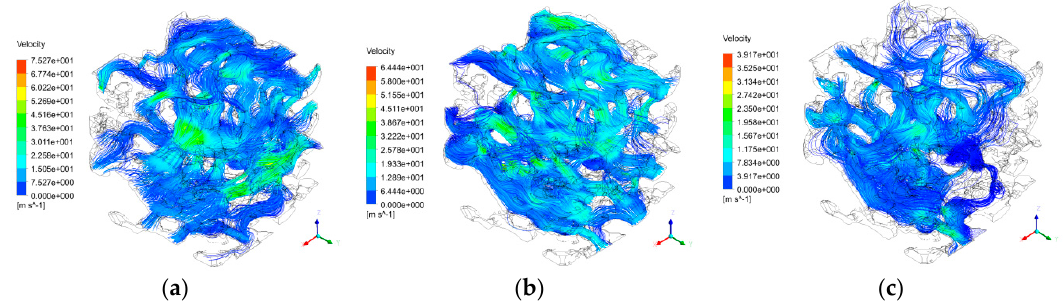
Figure 11. Distributions of seepage velocity subject to low-pressure water along single-channel in X , Y , and Z directions: ( a ) X direction; ( b ) Y direction; and ( c ) Z direction.